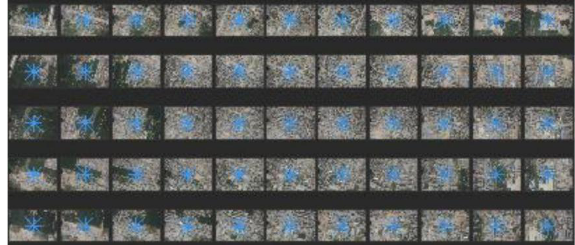
Figure 5. Internal orientation